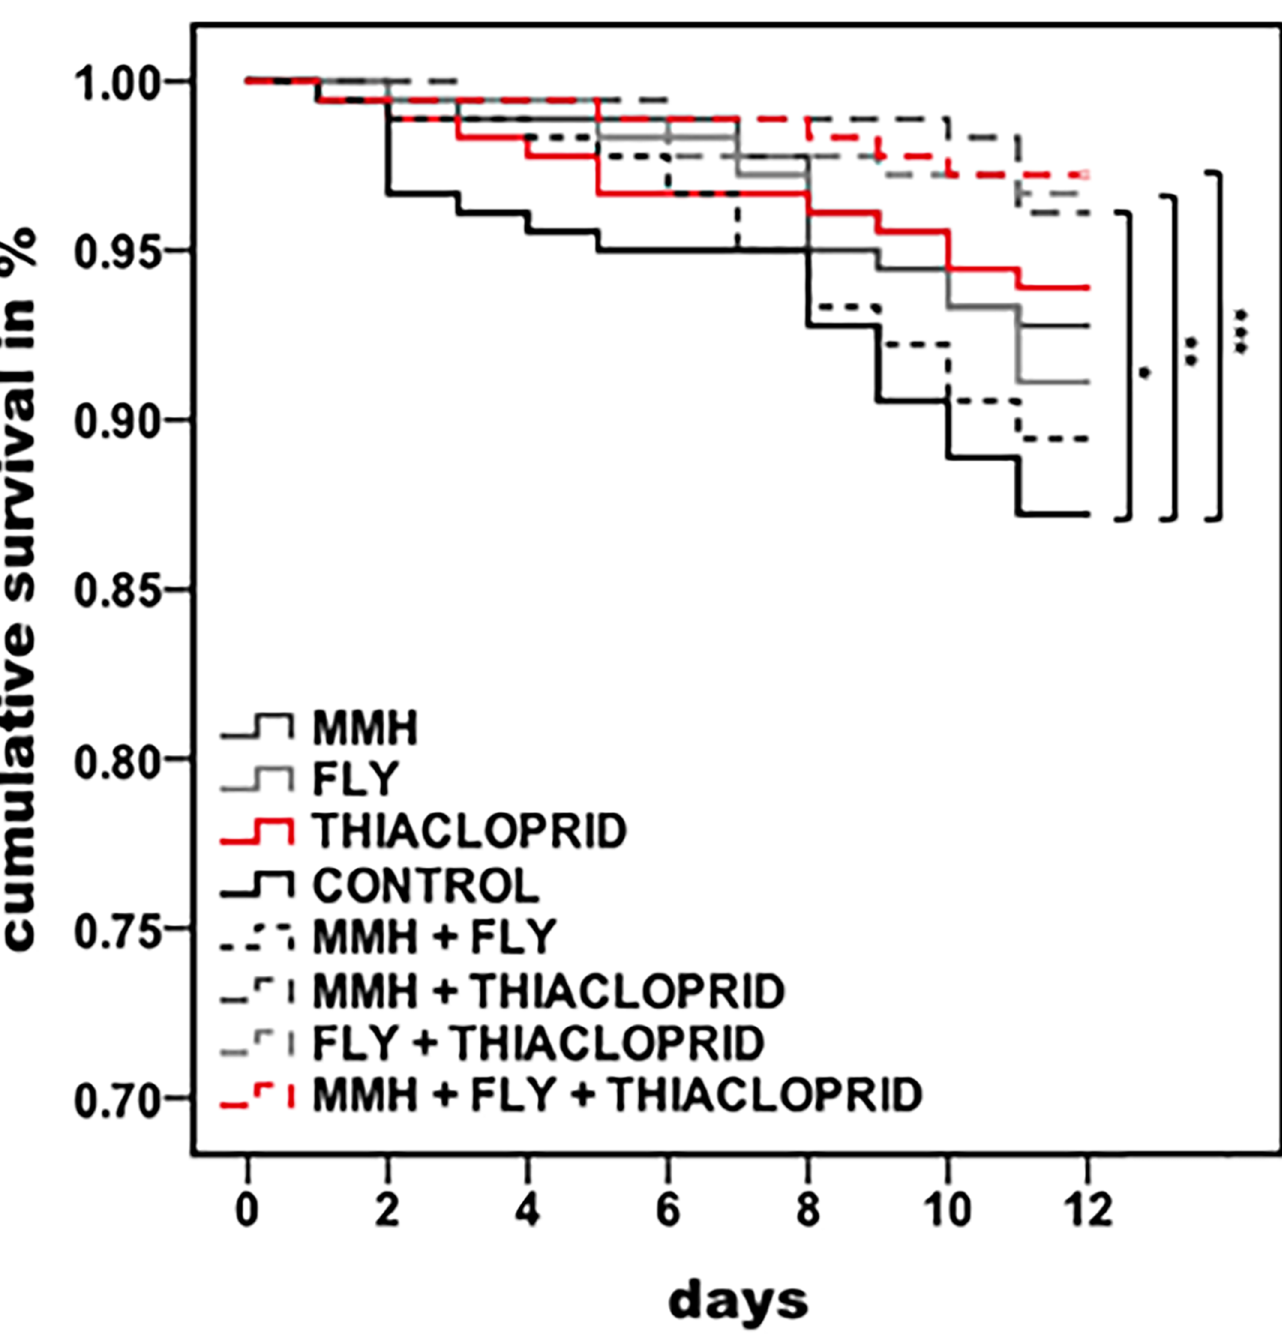
Fig 1. Effect of exposure to single and combined agricultural agents on honeybee survival. Survival is expressed as the percentage of cumulated number of surviving bees during the monitoring period of 11 days for each treatment group with n = 180 (MMH = E . faecalis strain MMH594, FLY = E . faecalis strain FLY1). Asterisks indicate differences in the survival rate after 11 days of individuals exposed to different stressors, (cid:3) (cid:20) 0.005, (cid:3)(cid:3) (cid:20) 0.001, (cid:3)(cid:3)(cid:3) (cid:20) 0.0001 (Kaplan-Meier survival analysis, log Rank test for overall comparison).